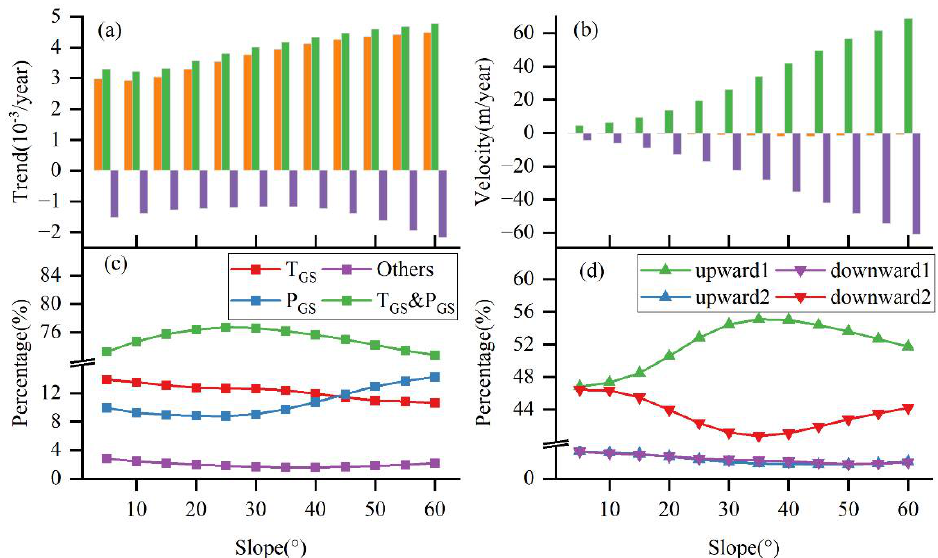
Figure 7. ( a ) Temporal rate of change of growing season NDVI (NDVI GS ) and ( b ) vertical velocity of vegetation greenness isolines within each 5 ◦ slope bin (Same comment as Figure 4). (the orange columns indicate the mean values for all pixels, the green columns the mean values for all positive pixels, and the purple columns the mean values for all negative pixels). ( c ) The percentage of pixels corresponding to each of the four driving-factor cases and ( d ) the percentage of pixels belonging to the different upward and downward categories within each 5 ◦ slope